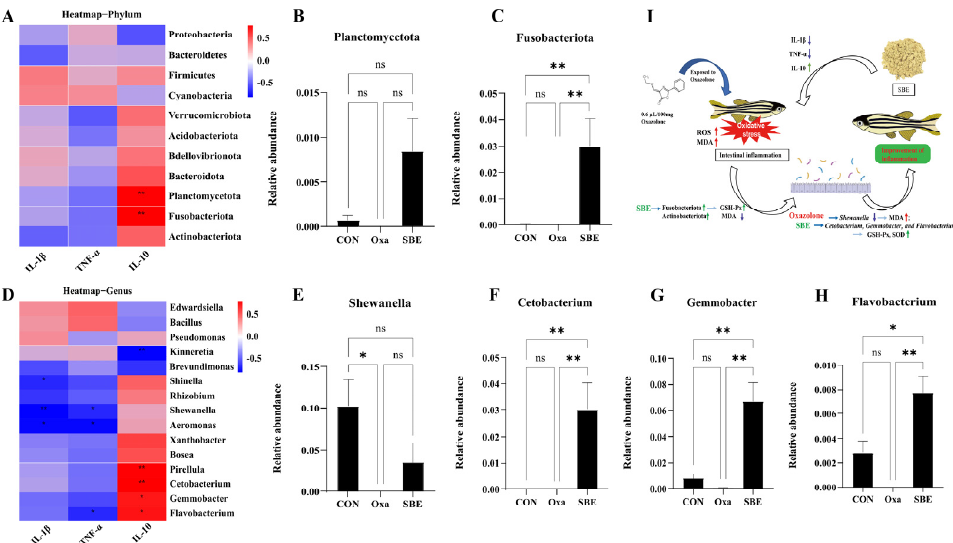
Figure 7. The correlation analysis between intestinal inflammatory factors and intestinal flora. Correlation between the mRNA expressions of TNF- α , IL-1 β , and IL-10 and intestinal microbiota at the phylum level ( A ). Histogram about the abundance of microbe that significantly correlated with the expression of IL-10 at the phylum level ( B , C ). Correlation between the mRNA expressions of TNF- α , IL-1 β , and IL-10 and intestinal microbiota at the genus level ( D ). Histogram about the abundance of microbe that significantly correlated with the expression of TNF- α , IL-1 β , and IL-10 at the genus level ( E − H ). Mechanistic diagram of SBE regulating inflammatory factors via intestinal flora in zebrafish ( I ). A redder color indicates a positive correlation, while a bluer color indicates a negative correlation (* p < 0.05, ** p < 0.01. n ≥ 3/per group).